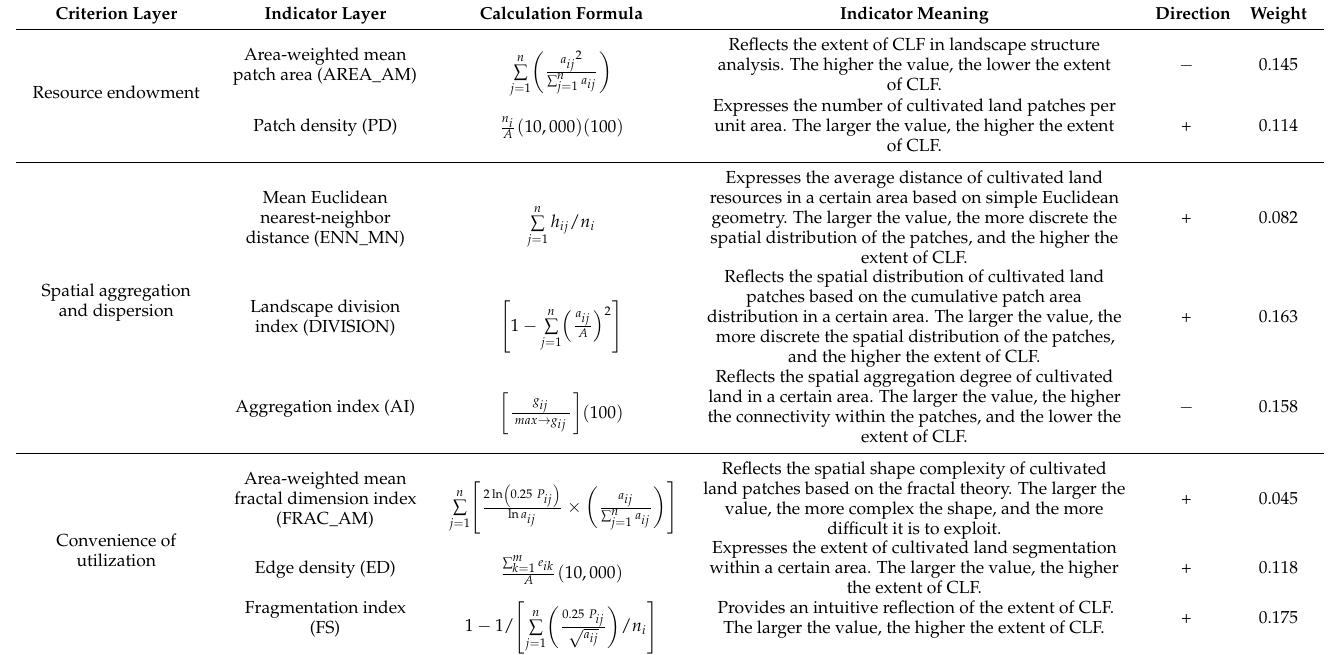
Table 1. Evaluation index system of CLF on the county scale in Guangdong Province.